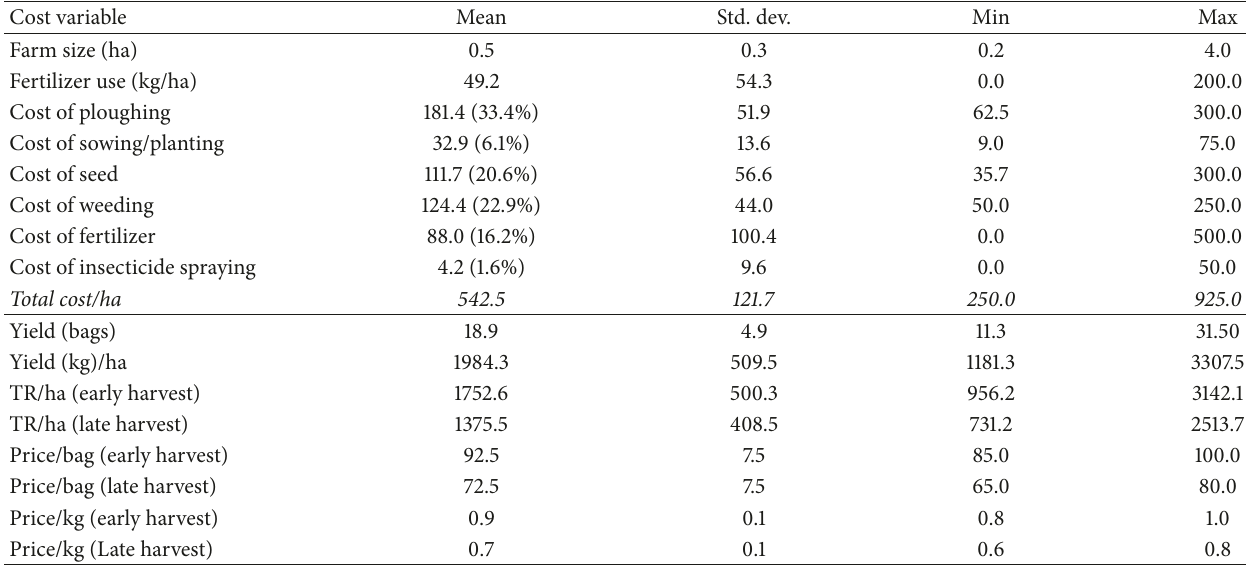
Table 4: Farm size and cost and revenue structure analyses of sweet potato production in Northern Ghana.